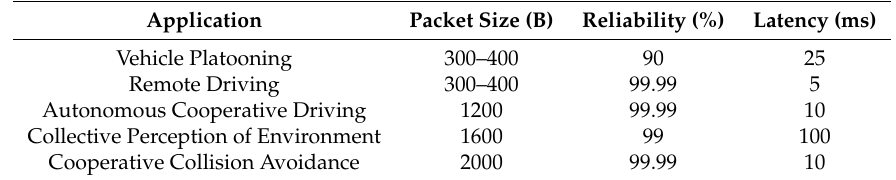
Table 3. Payload size, reliability, and latency requirements for prospective 5G eV2X applications.